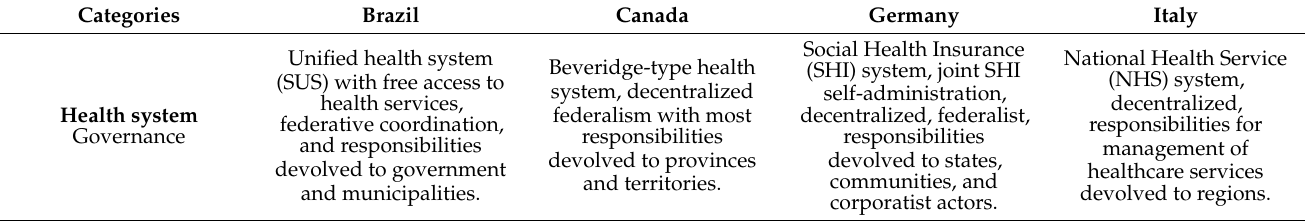
Table 2. Health system and health workforce indicators in four selected country cases: a comparative descriptive overview of basic